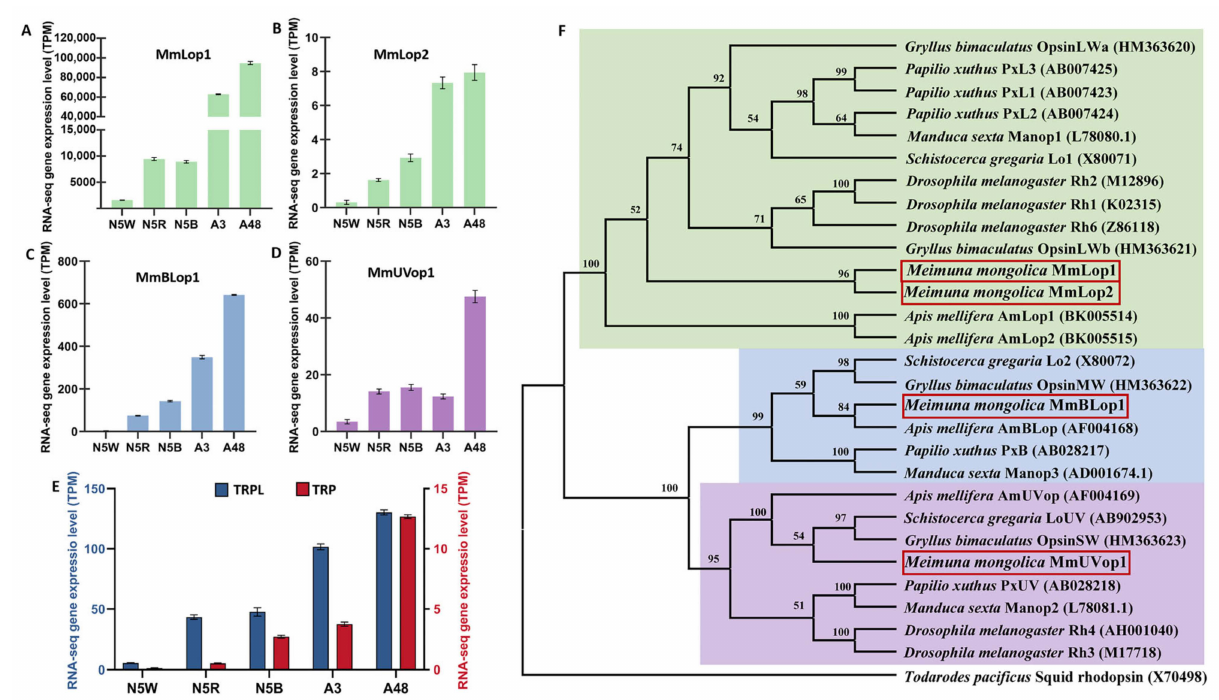
Figure 6. Expression analysis of six genes related to phototransduction and phylogenetic analysis of four opsin genes in M. mongolica . ( A – E ) RNA-seq gene expression levels of MmLop1, MmLop2, MmBLop1, MmUVop1, TRP and TRPL on five development stages (N5W, N5R, N5B, A3, A48). The 5th-instar with white compound eyes (N5W), with red compound eyes (N5R), with dark brown compound eye (N5B), and the adults after emergence at 3 h (A3), 48 h (A48). ( F ) The phylogenetic tree was based on the maximum likelihood (ML) method. Different opsin nucleotide sequences are grouped into four clusters, which belong to three orders and an outgroup, and are assigned with different colors. Numbers at nodes indicate the bootstrap values. The 29 sequences are indicated by the corresponding scientific names of species followed by their gene names and accession numbers. The sequences of four opsins studied in our study are indicated by solid red rectangular